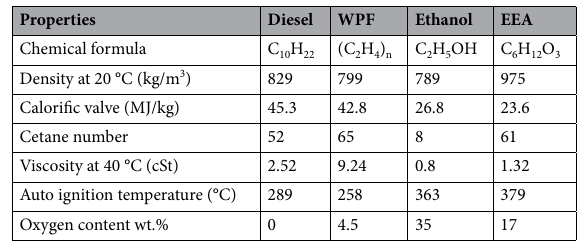
Table 2. Fuels properties utilized for quaternary fuel combination.